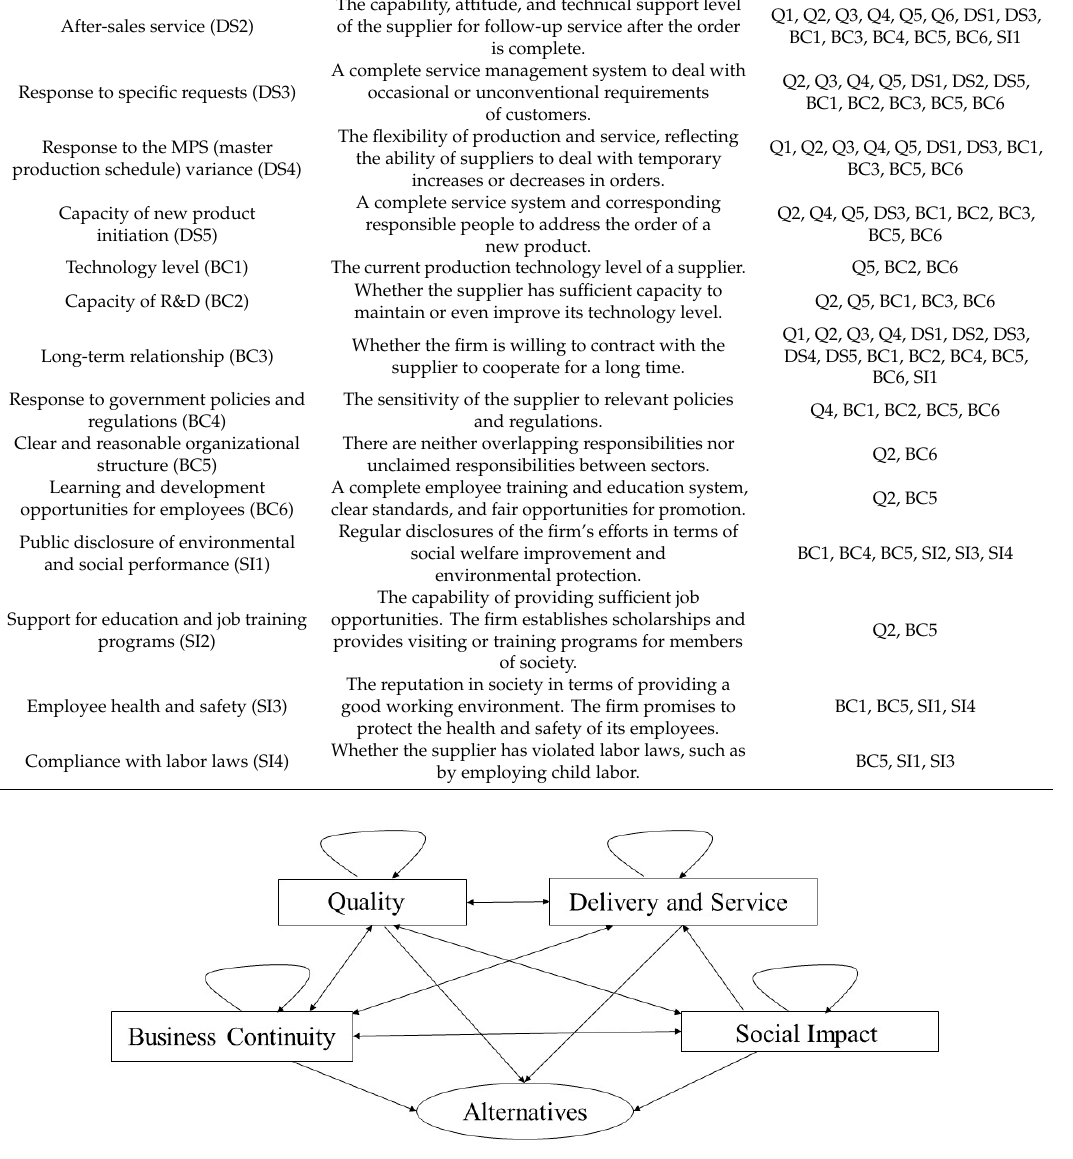
Figure 2. The relationships between the clusters.